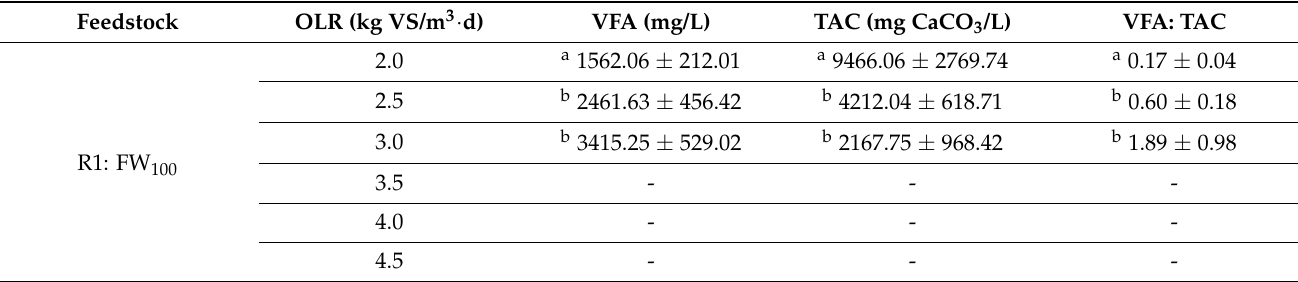
b 1.21 ± 0.26 a Values are means of data recorded during the 8 weeks of the experiment ± SD; b Values are means of data recorded during the 4 weeks of the experiment ± SD; (-) No measurement of process performance indicators. One of the main objectives of this experimental work was to evaluate the effects of agricultural and industrial waste on FW anaerobic process performance operated at dif- ferent OLRs. Figure 5 shows that SBY profiles changed during the different experimental phases, as well as the nature of the feedstock used. At an OLR of 2.5 kg VS/m 3 ·d, R2 demonstrated an improvement of 24% of SBY during the transitional period from Phase I